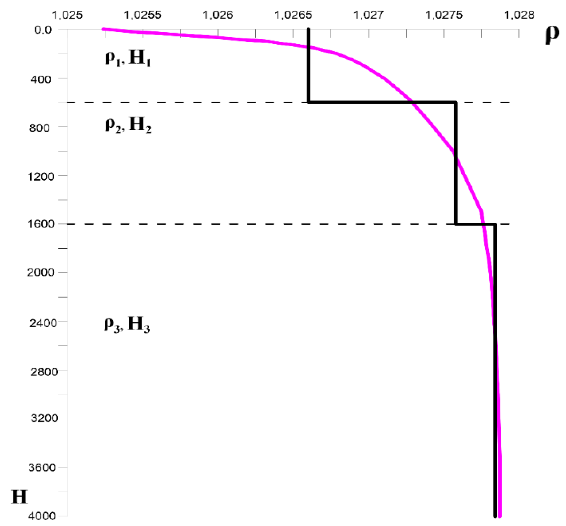
Figure 1. The average annual vertical density profile (solid magenta line) characteristic for the Atlantic [21] and its piecewise constant approximation (solid black line). Dashed lines indicate undisturbed interfaces between layers.